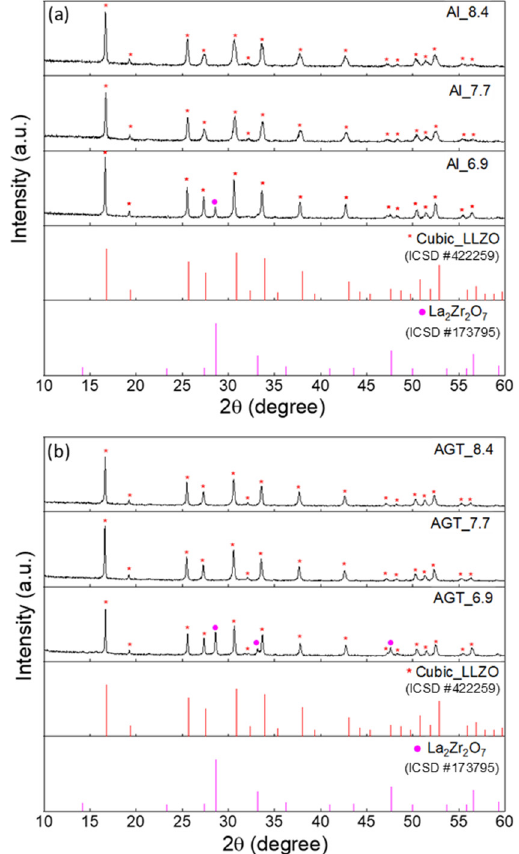
Figure 1. XRD patterns of ( a ) Al-doped LLZO powders and ( b ) Al/Ga/Ta-doped LLZO powders with different Li + concentrations (6.6, 7.7, and 8.4 mol). The peaks marked by red and purple dots are attributed to cubic LLZO and La 2 Zr 2 O 7 , respectively. The red and purple vertical lines represent the standard diffraction peaks of cubic LLZO and La 2 Zr 2 O 7 , respectively.